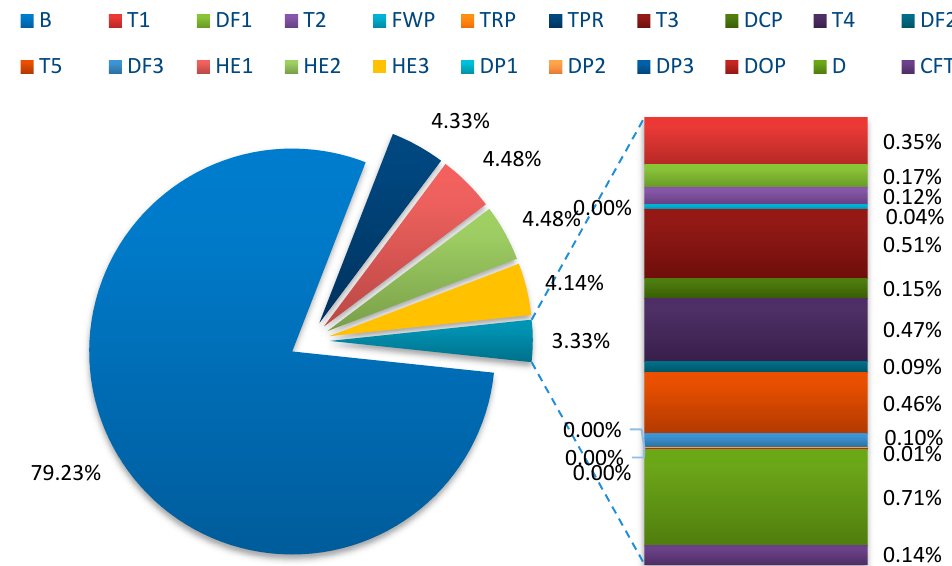
Figure 5. Percentage of each component’s exergy destruction of the total exergy destruction.